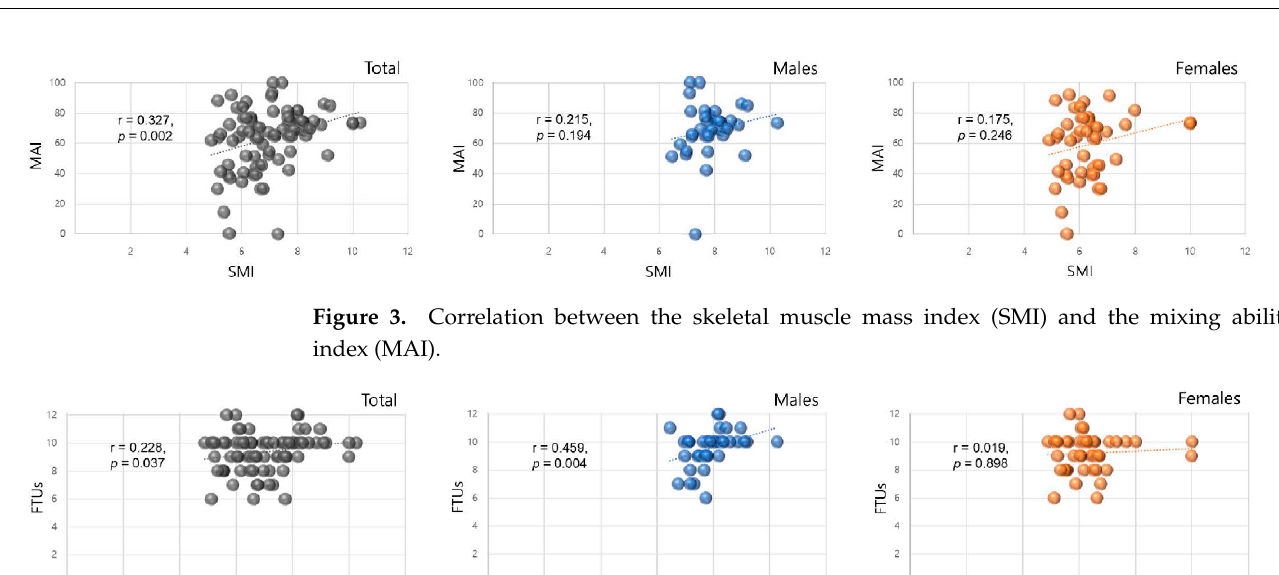
Figure 2. Correlation between functional tooth units (FTUs) and the mixing ability index (MAI).